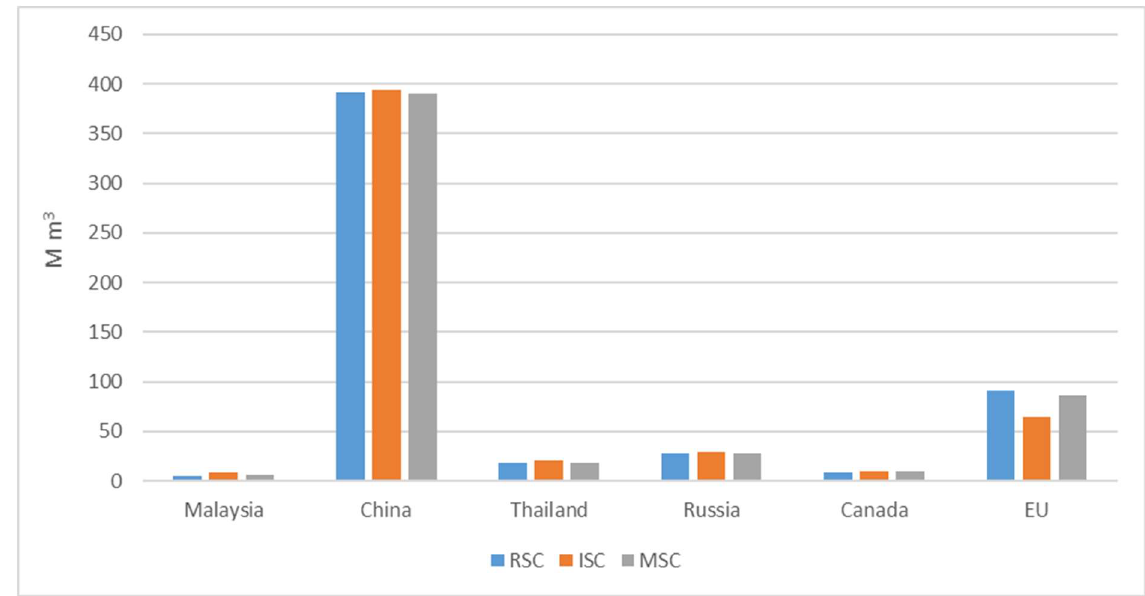
Figure 8. Wood-based panels production (including veneer and plywood) of the countries with the greatest changes (ranking of countries is according to changes in ISC vs. RSC) and the EU: RSC (blue), ISC (orange) and MSC (grey) in 2050 [authors’ results].